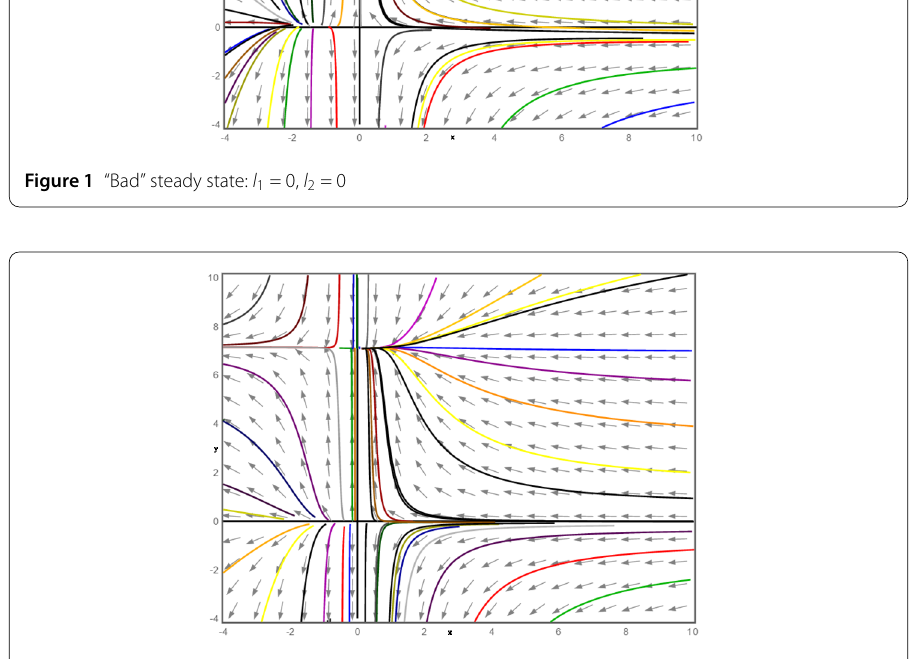
Figure 2 “Bad” steady state: l 1 = 0.3225138920, l 2 = 0